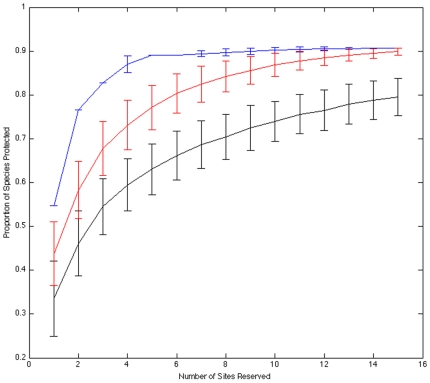
Reserve network performance under three selection scenarios: 1) sites selected at random (black line), 2) sites selected by choosing the single richest site from each jurisdiction (red line), and 3) sites selected by choosing the richest sites regardless of jurisdiction (blue line).We used the 15 country designations specified in the AGRRA database as our jurisdictional units. Each line represents the proportion of all species protected as a function of the number of reserved sites under each of the three scenarios. Error bars are ±1 standard deviation. For scenarios 2 and 3, when two or more sites had the same richness, one of these sites was selected at random (thus, scenario 3 has error bars). Similarly, when selecting fewer sites than the total number of jurisdictions considered in scenario 2, we randomly identified jurisdictions to choose sites from (thus, error bars decrease as the number of reserves approaches the number of jurisdictions).